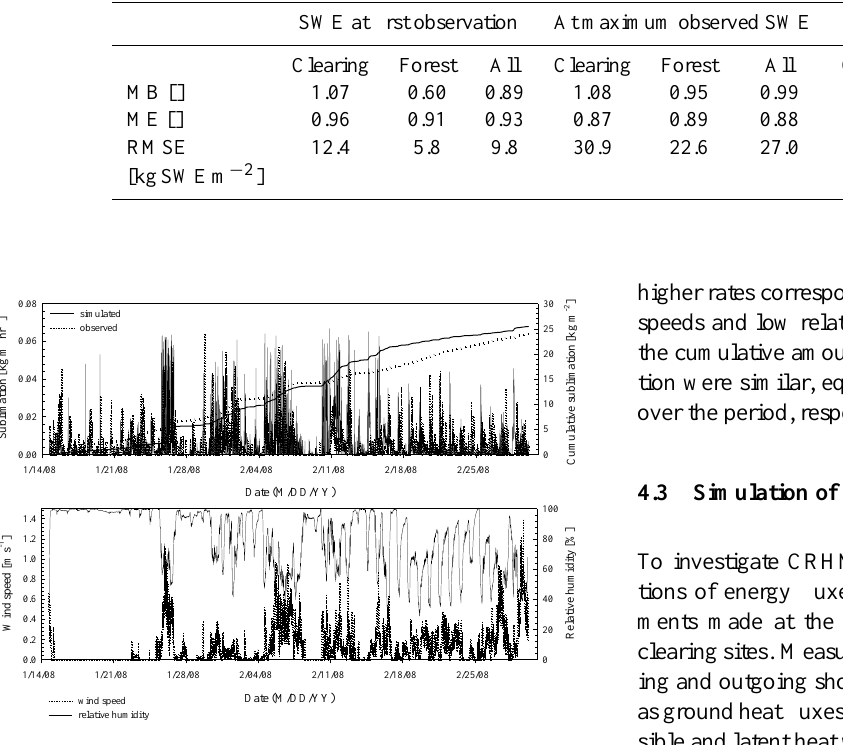
Figure 5. Fig. 5. Top: observed and simulated hourly (and cumulative) canopy snow sublimation; bottom: corresponding observations of forest wind speed and relative